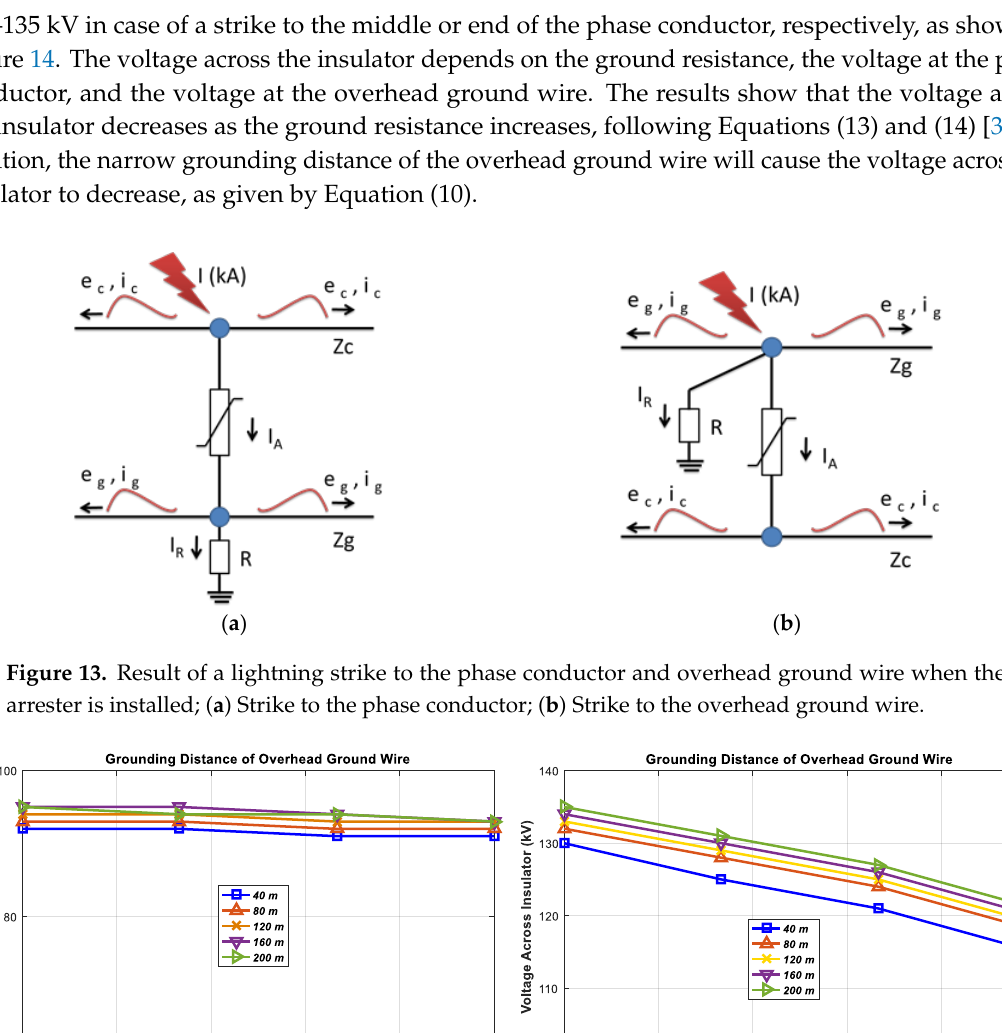
Figure 14. Voltage across the insulator as a result of a lightning strike to the phase conductor (lightning current wave shape = 4.12/77.5 μs, lightning current = 40 kA); ( a ) Strike to the middle of the phase conductor; ( b ) Strike to the end of the phase conductor.